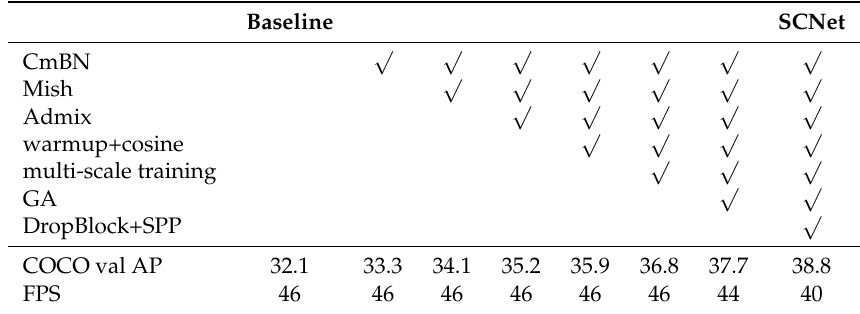
Table 1. The effect of each trick on the baseline network. All of the listed design decisions generate presentable performance gains in AP—evaluated on the COCO val split.